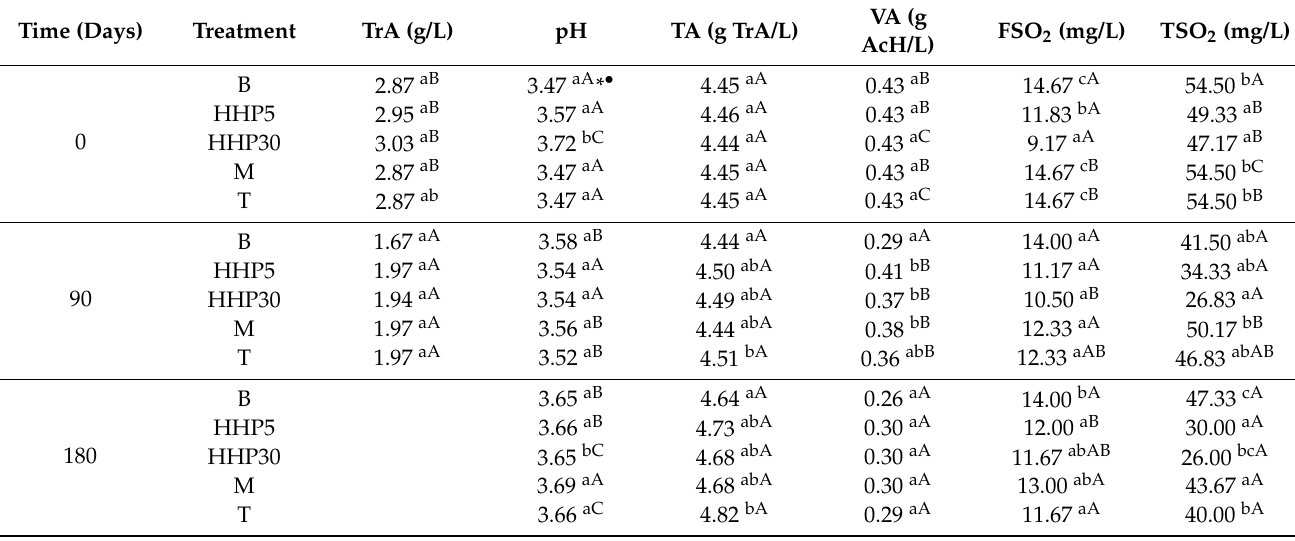
B: Wines bottled without any treatment; HHP5, HHP30: Wines bottled after maceration of holm oak chips (5 g/L) with HHP treatments (400 MPa, 5 and 30 min). M and T: Wines bottled after storage for 45 days in tanks with and without maceration of holm oak chips (5 g/L). TrA: Tartaric acid; TA: Total acidity; VA: Volatile acidity; Ach: Acetic acid; FSO 2 : Free SO 2 ; TSO 2 : Total SO 2 . * Different lower case letters indicate a significant difference ( p < 0.05) among the treatments for the same day. • Different capital letters indicate a significant difference ( p < 0.05), for the same treatment on different